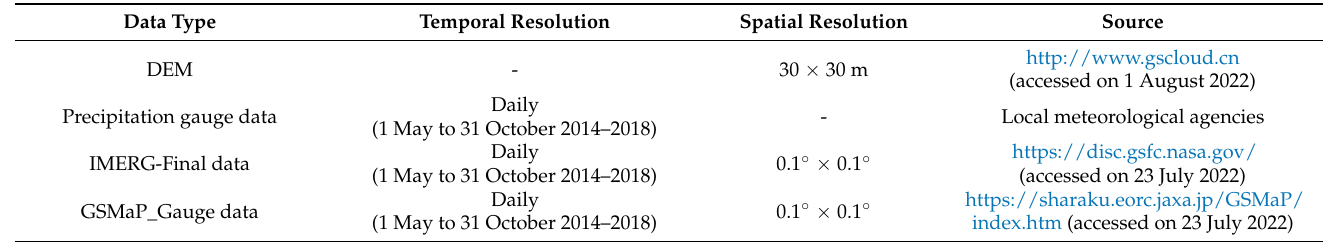
Table 2. Data type, resolution, and sources of precipitation used in this study.